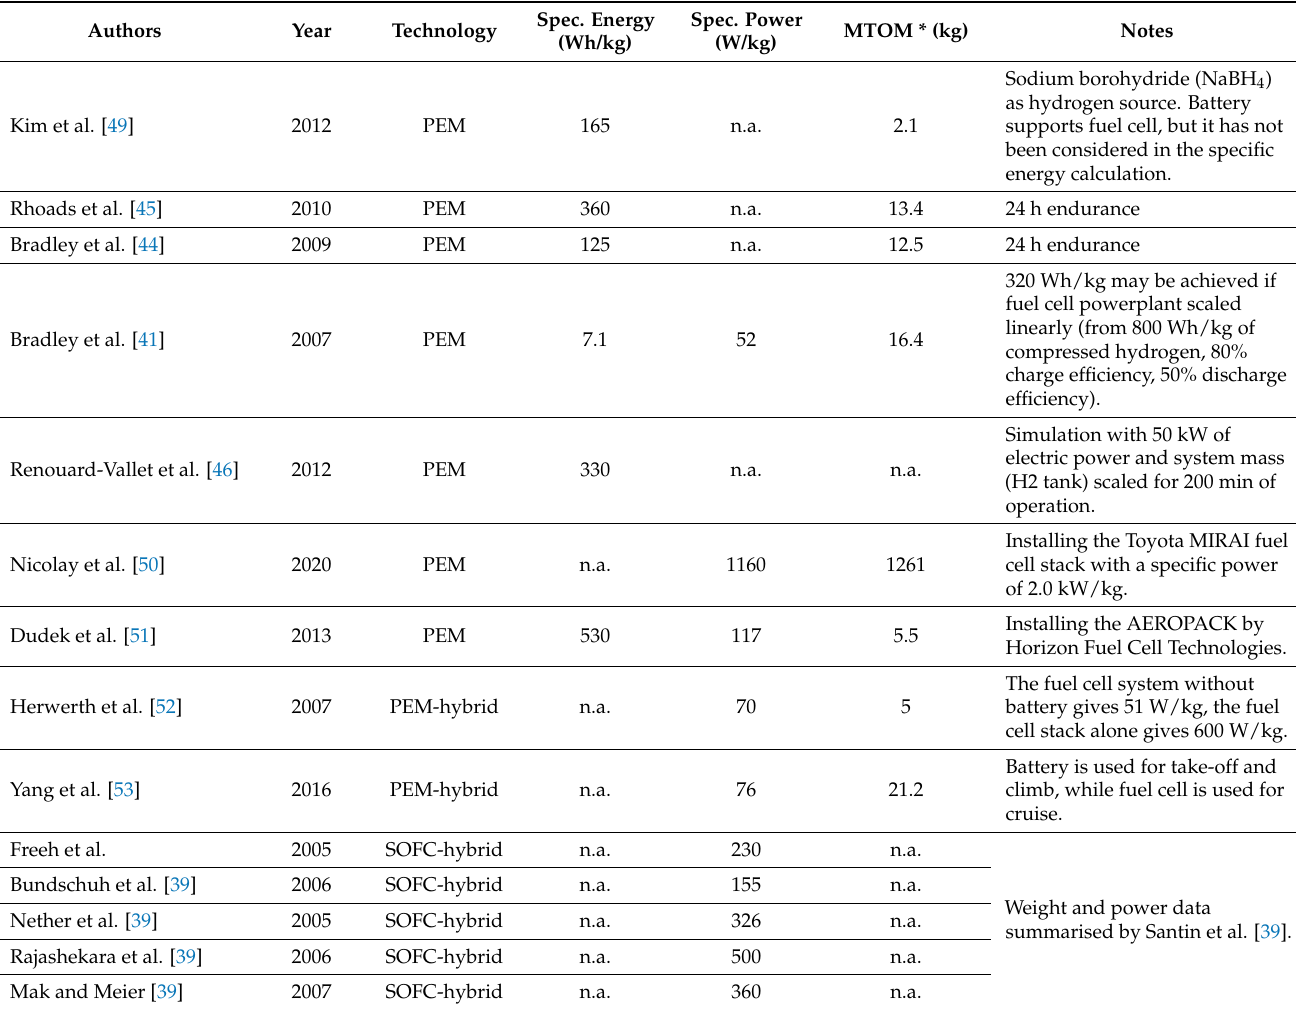
Table 5. Fuel cells performance in aircraft applications. Specific energies and powers refer to the fuel cell system (including tank,